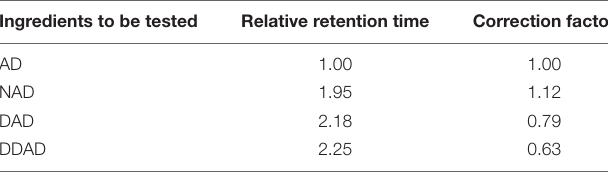
TABLE 2 | Relative retention time and correction factor of AP diterpene lactone